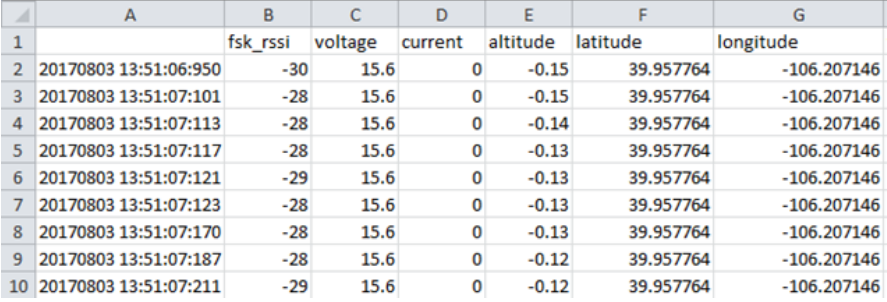
Figure 9. Content of flight logs.